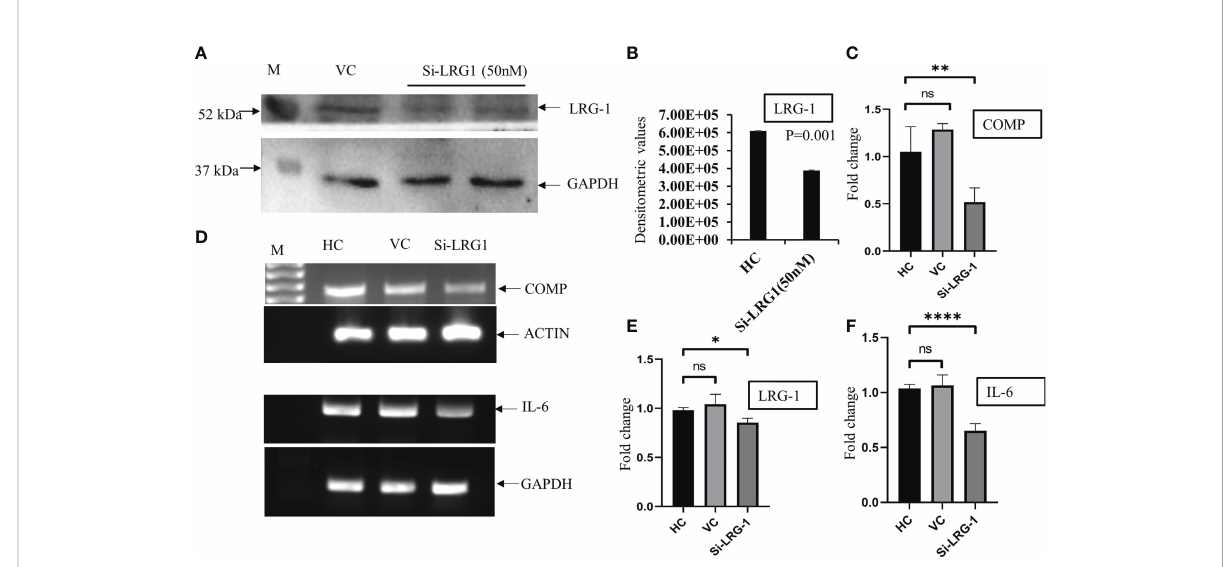
FIGURE 4 LRG1 promotes fi brosis in primary synovial cells. Western Blot (WB) and agarose gel images were taken by Chemidoc (Bio-Rad, Hercules, CA, USA), and densitometry analysis of all the images was carried out using Image Lab V6 (Bio-Rad). All graphs were generated and the statistical analysis carried out using GraphPad Prism (version 8.4.686). Data are presented as the mean ± standard deviation (SD). Paired Student ’ s t -test was applied for groups comparisons in (B) to show statistical signi fi cance, while one-way ANOVA was used for group comparisons in (C, E, F) . (A) Western blot image showing LRG1 knockdown using siRNA (50 nM) in primary fi broblast-like cells isolated from OA synovium. The upper panel shows the LRG1 expression level with the transfection reagent for 48 h, while the lower panel shows GAPDH as the loading control in the respective sample. (B) Bar graph plotted using the densitometric values after the analysis of bands depicting the 60% downregulation of the LRG1 expression after knockdown using siRNA. (C) Bar graph showing the mRNA level of COMP after the knockdown of LRG1 in OA primary cells compared to the vehicle control group. (D) PCR products run on 1% agarose gel for visualization of the mRNA expression levels of IL-6 and COMP after treatment with siRNA. (E) Bar graph showing the mRNA level of LRG1 after knockdown. (F) Bar graph showing the mRNA level of the in fl ammatory marker IL-6 after the knockdown of LRG1 compared to the untreated groups. * p ≤ 0.05; ** p ≤ 0.01; **** p ≤ 0.0001. ns , non-signi fi cant; LRG1 , leucine-rich alpha-2 glycoprotein; OA , osteoarthritis; COMP , cartilage oligomeric matrix protein; IL-6 , interleukin 6; VC , vehicle group; HC , healthy control; GAPDG , glyceraldehyde-3-phosphate